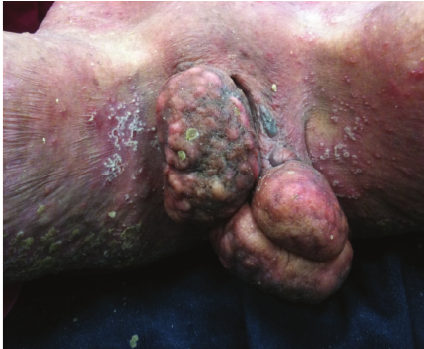
Figure 1: Giant bilateral labial fibroepithelial stromal polyps in patient with psoriasis disease.